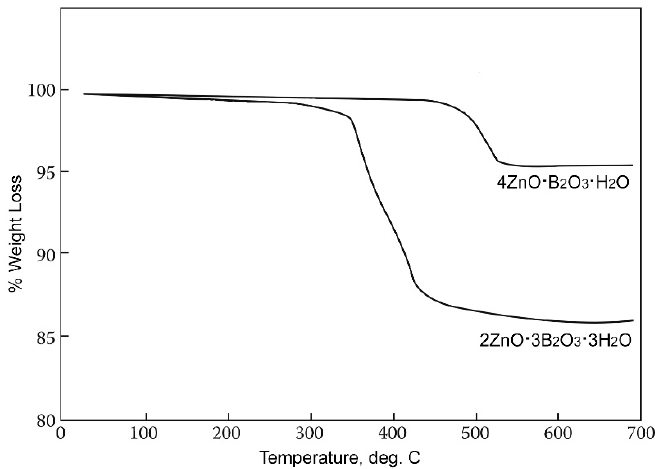
Figure 3. TGA scans of Zn[B 3 O 4 (OH) 3 ] (ZnO ∙ 3B 2 O 3 ∙ 3H 2 O) and Zn 2 (BO 3 )OH (4ZnO ∙ B 2 O 3 ∙ H 2 O).